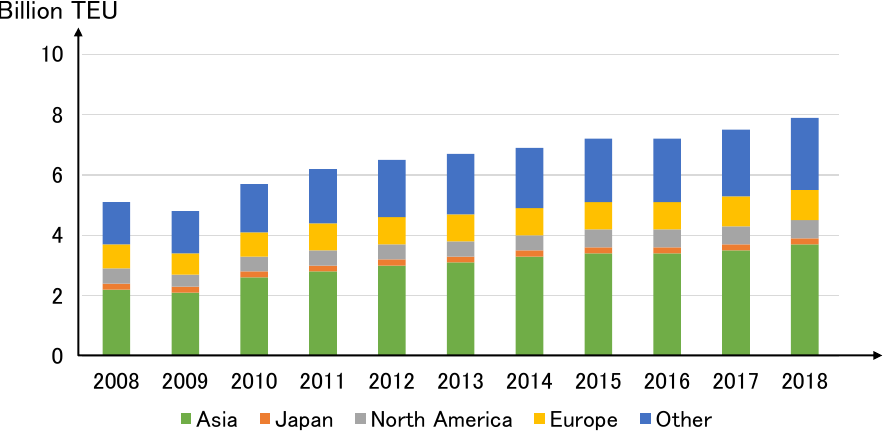
Figure 1. Growth in number of containers over last 10 years from 2008 to 2018 [3].